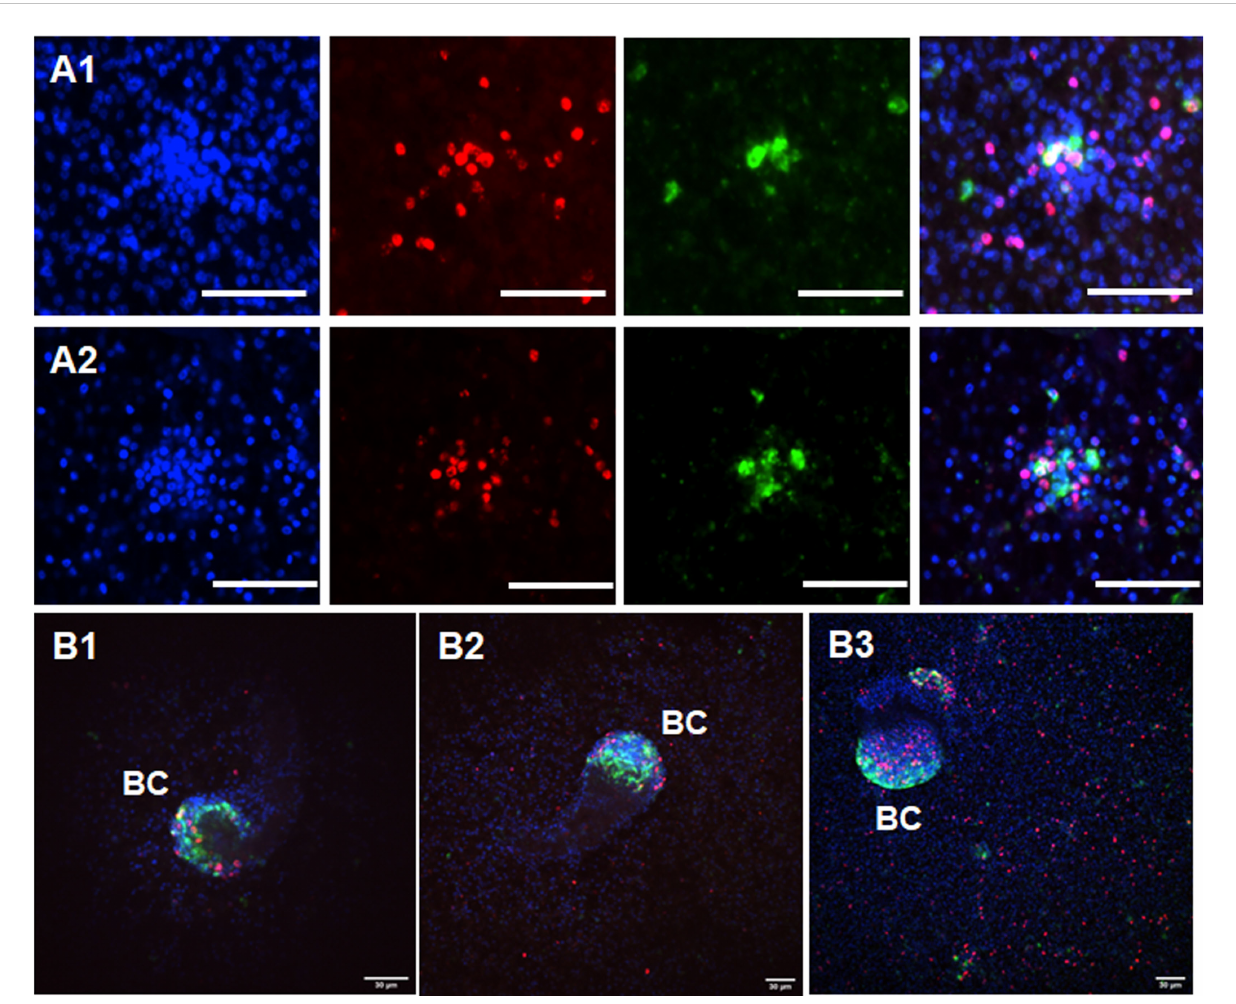
FIGURE 8 Expression of Emact in BC. Two examples of representative WISH images are shown for Emact expression in early BC in (A1, A2) . Shown from left to right are DAPI channel (nuclei, blue), EdU (S-phase stem cells, red), Emact (green), and merge of all three channels. Bar indicates 30 µm. (B1 – B3) shows three examples of BC in different stages of development. Channels are as in (A1, A2) , shown are merge images of all three channels. BC indicates brood capsules. Bar represents 30